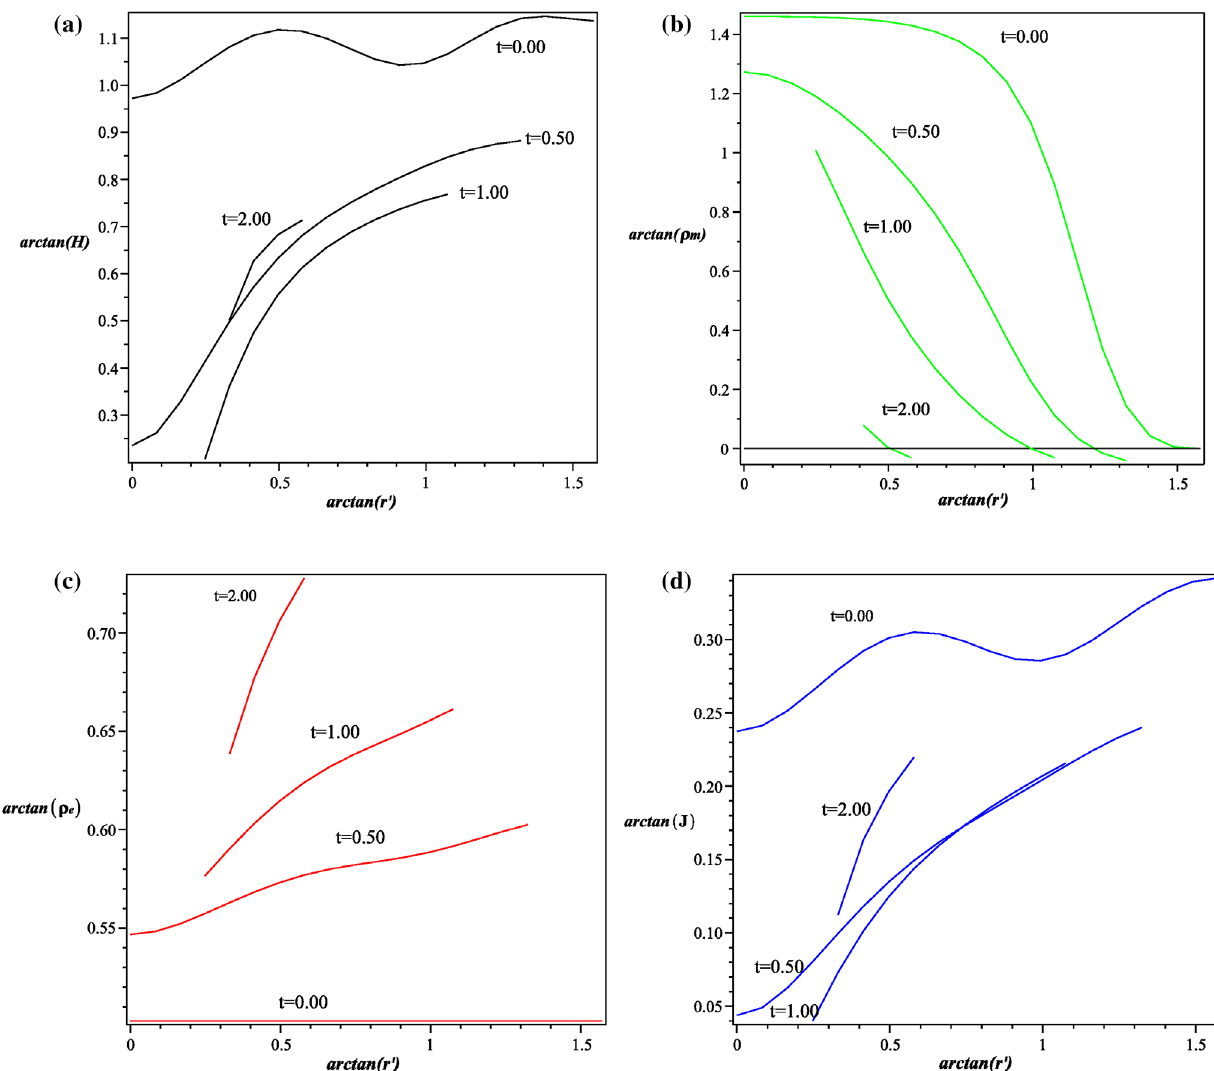
Fig. 8 Profiles of different local scalars for the configuration with initial conditions given by (31) and w = − 1 . 0, α = − 0 . 1 at different instants of time. a scalar H . b scalar ρ ( m ) . c scalar ρ ( e ) . d scalar J . Refer to the text for a detailed discussion of the